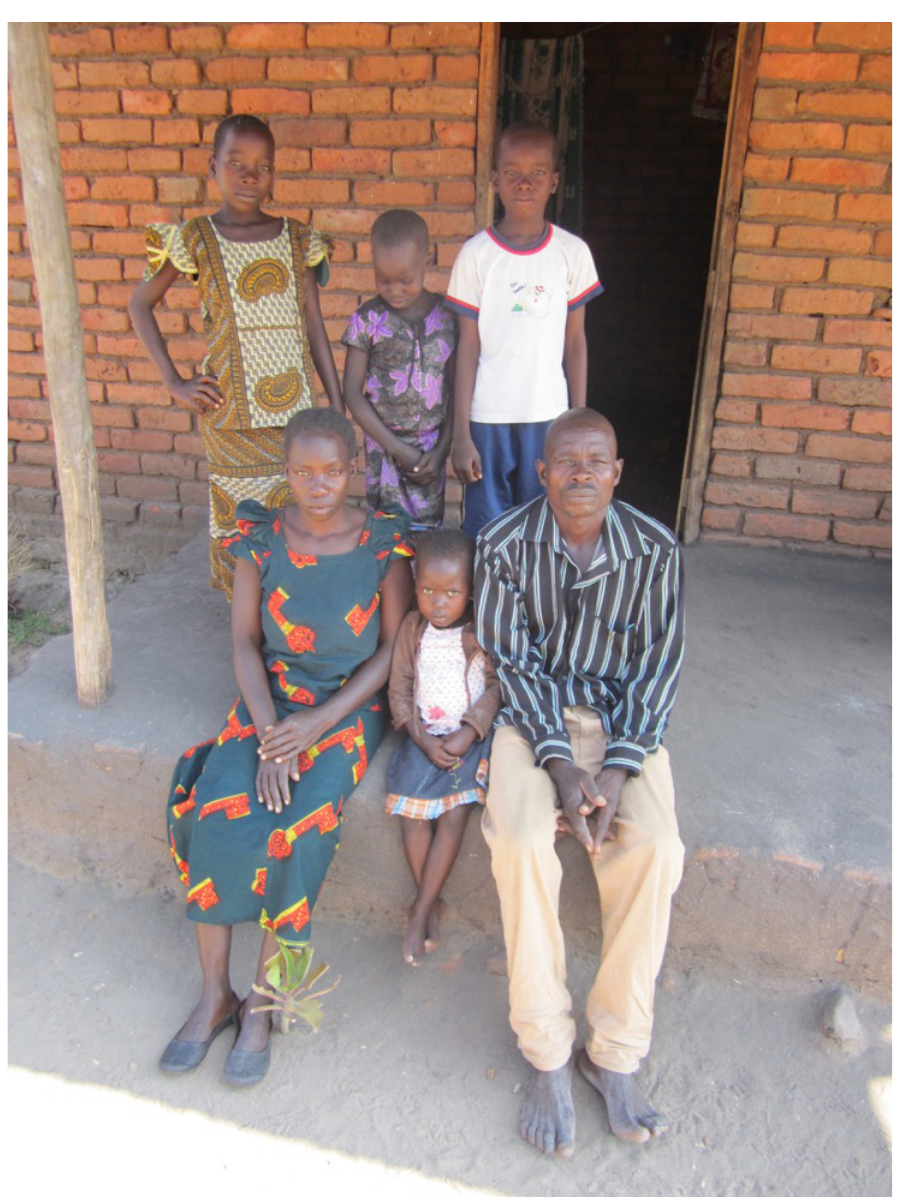
Photograph 7: Farmer (44) with his first wife and their